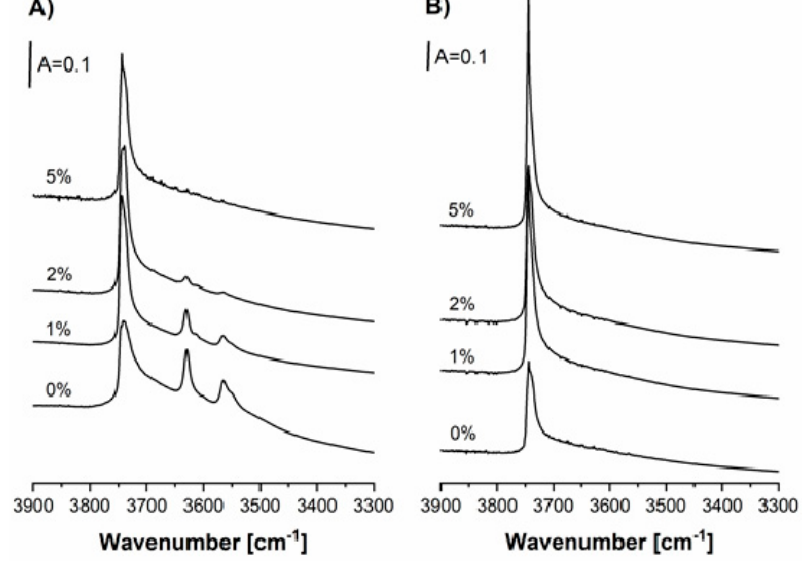
Figure 2. IR spectra of OH groups in zeolites CuHFAU ( A ) and CuNaFAU ( B ) of various Cu